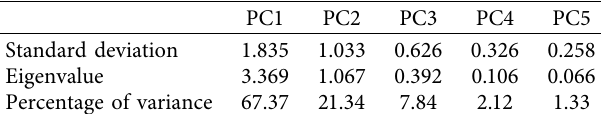
Figure 3: Principal component plot. Table 10: Principal components.